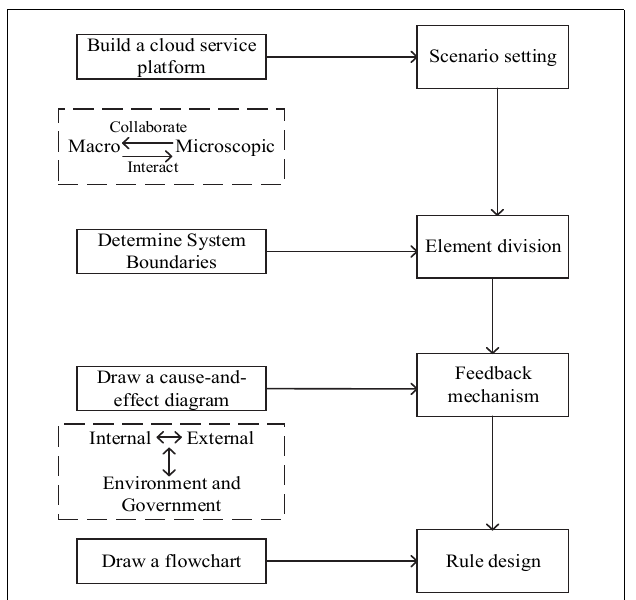
FIGURE 1 | Third part of the research